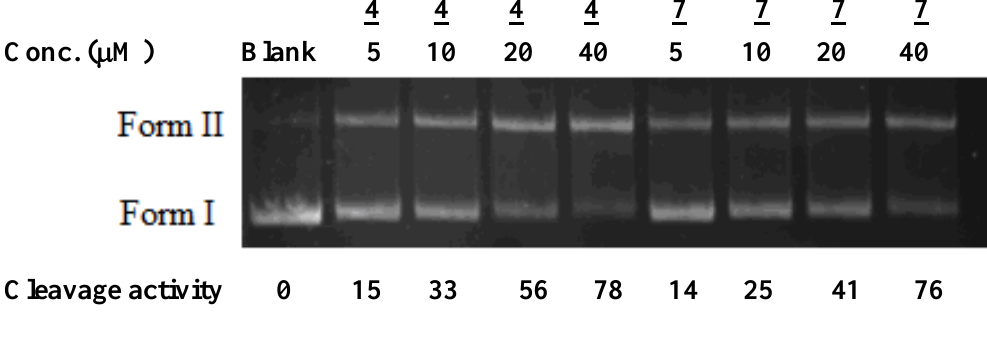
Figure 1. The relation between illumination time and DPBF’s absorption value ratio ( A/A